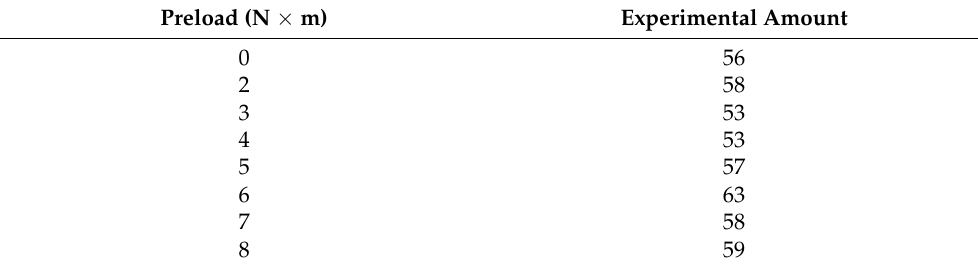
Table 1. Directly collected data distribution.